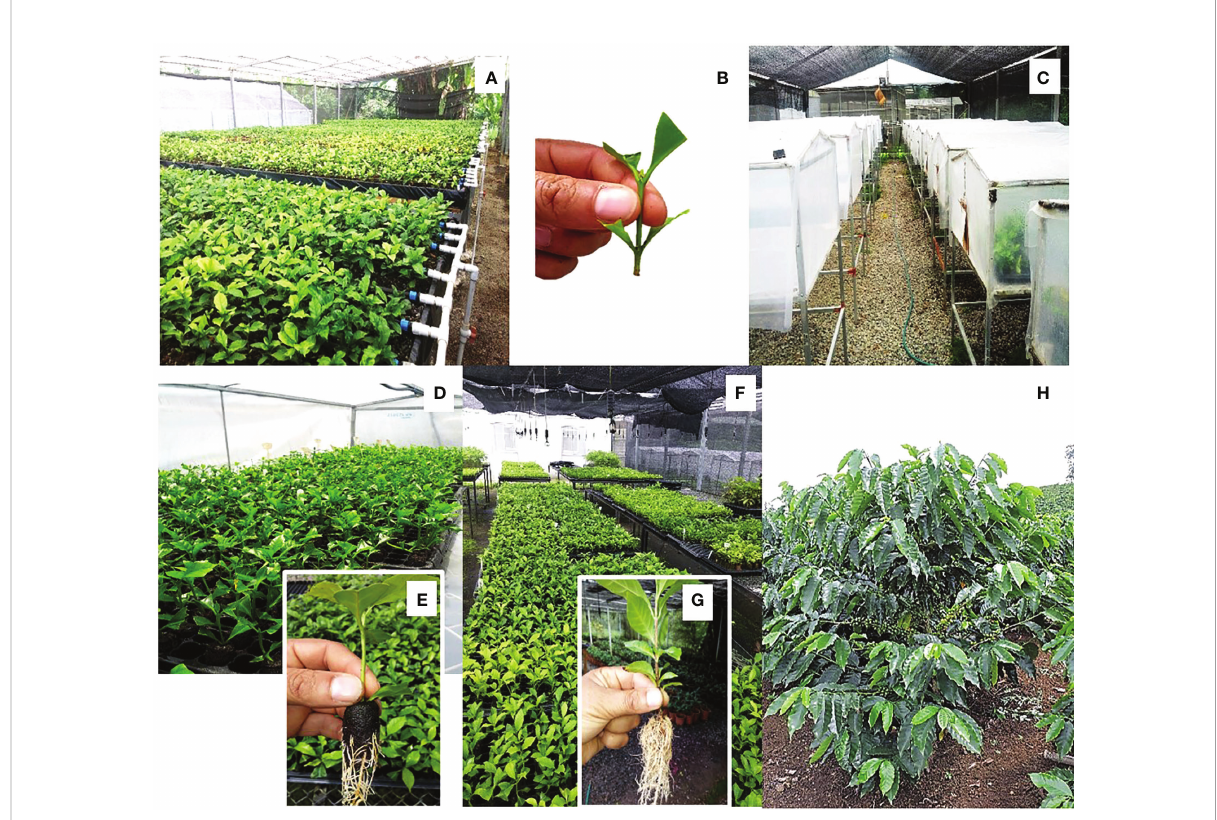
FIGURE 7 Clonal propagation of coffee mother plants from rooted cuttings. (A) Hydroponic garden with mother plants from SE; (B) prepared cutting 7 cm long, with two nodes and four pruned leaves; (C) exterior of the tunnels for rooting cuttings; (D) interior of the tunnels for rooting; (E) cutting rooted in ‘ Jiffy ® ’ pellets after 40 days in the rooting tunnels; (F) greenhouse for acclimatization of newly rooted plants before their transfer to the nursery; (G) root system of a rooted cutting; (H) plant derived from a rooted cutting, 1 year of age, CATIE, Costa